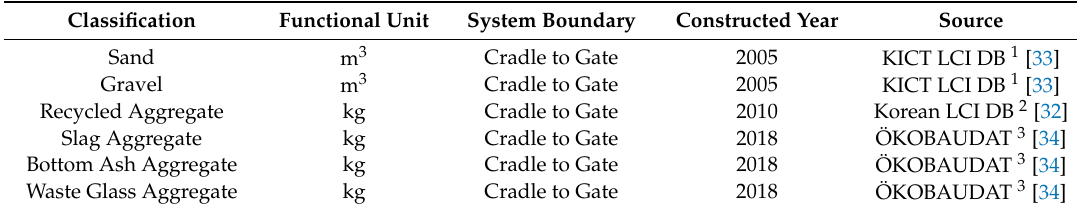
Table 1. LCI DB Information for the Natural, Recycled, and By-product